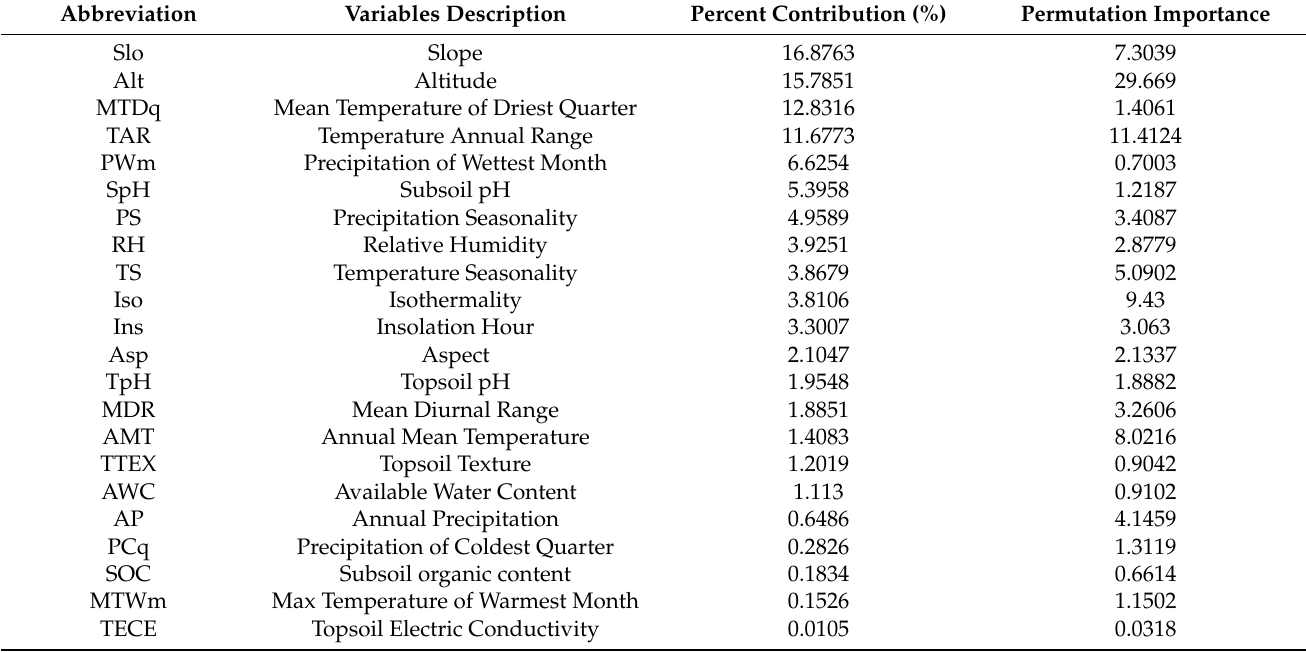
Table 1. Percentage contributions and permutation importance of the environmental